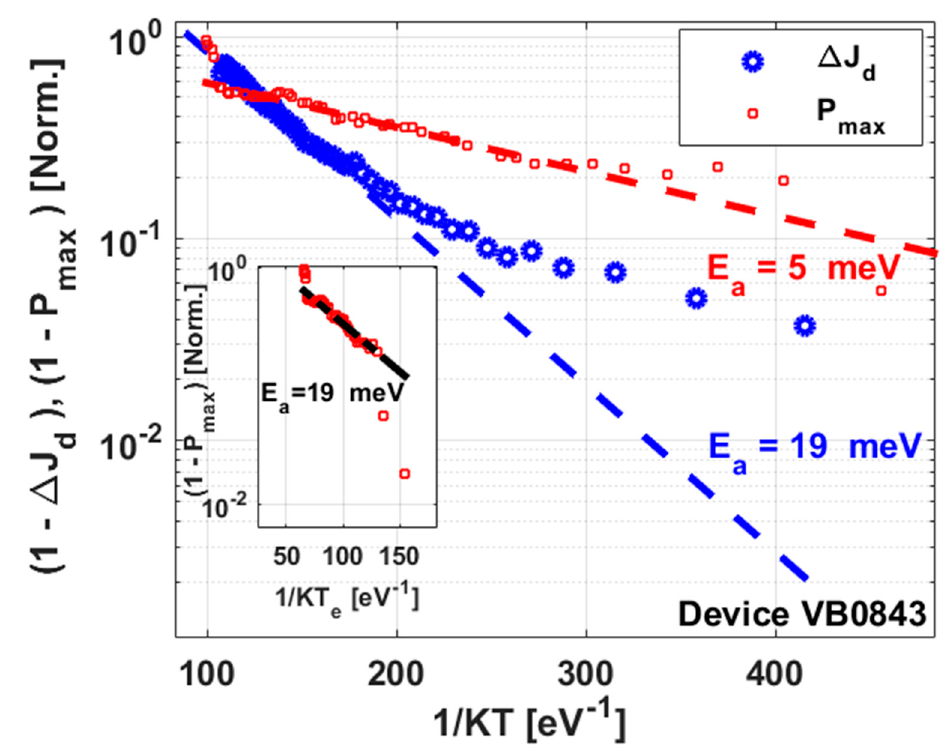
Figure 4. Activation energy extracted from the current dynamic range ∆ J d = (J max − J th ) (blue circles) and the laser’s maximum power output ( P max ) (red squares), for Device 1 (wafer VB0843). The quantities ∆ J ( T ) d ( T ) ∆ in the y -axis are 1 − and 1 − P out respectively presented in logarithmic scale. Including a characteristic excess temperature of 60 K in an Arrhenius plot presentation as a function of the total electron temperature rather than the lattice one results in an activation barrier of 19 meV for the laser’s maximum power output ( P max ) (red squares) data (inset), similarly to the current dynamic range Δ J d = (J max − J th ) (blue circles) data with zero excess electron temperature at the main figure.